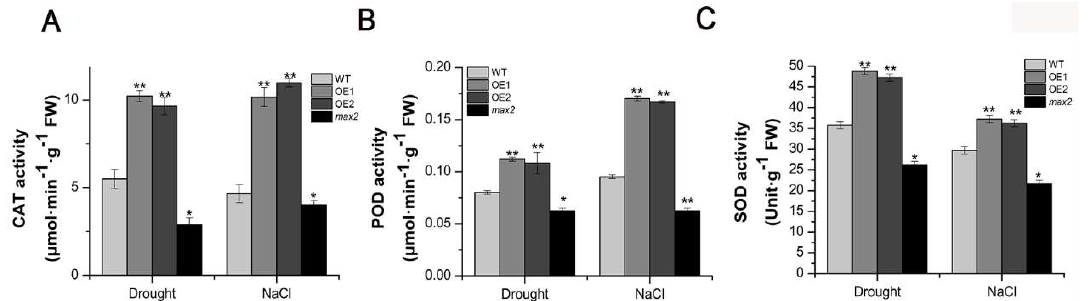
Figure 8. SsMAX2 increased the activity of the antioxidant enzymes. The enzyme activities of ( A ) CAT, ( B ) POD, and ( C ) SOD of the extracts of 15-day-old seedlings were separately determined 5 days after withholding water or 150 mM NaCl treatment. Data are presented as means ± SD of three biological replicates. Significant differences between WT and the other groups were determined by Student’s t -test. Significance level: * p < 0.05, ** p < 0.01.